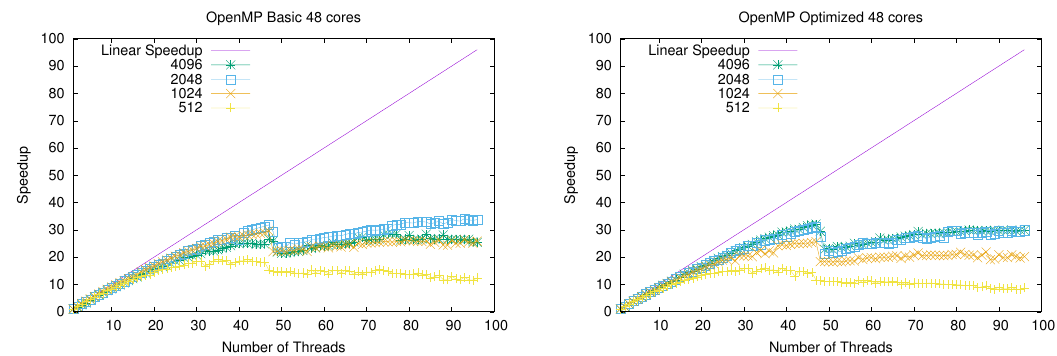
Figure 2. Speedup of the parallel OpenMP implementation running on a consumer-oriented CPU with eight cores. ( Left ): Basic implementation without in-depth optimization. ( Right ): Fully optimized implementation.